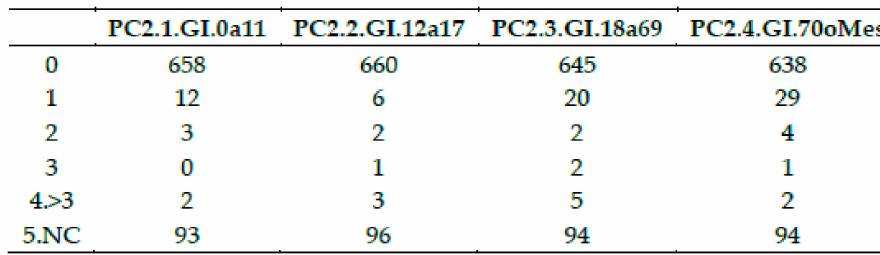
Figure 29. Cross table of PC2.GrauIaCarrec per levels.